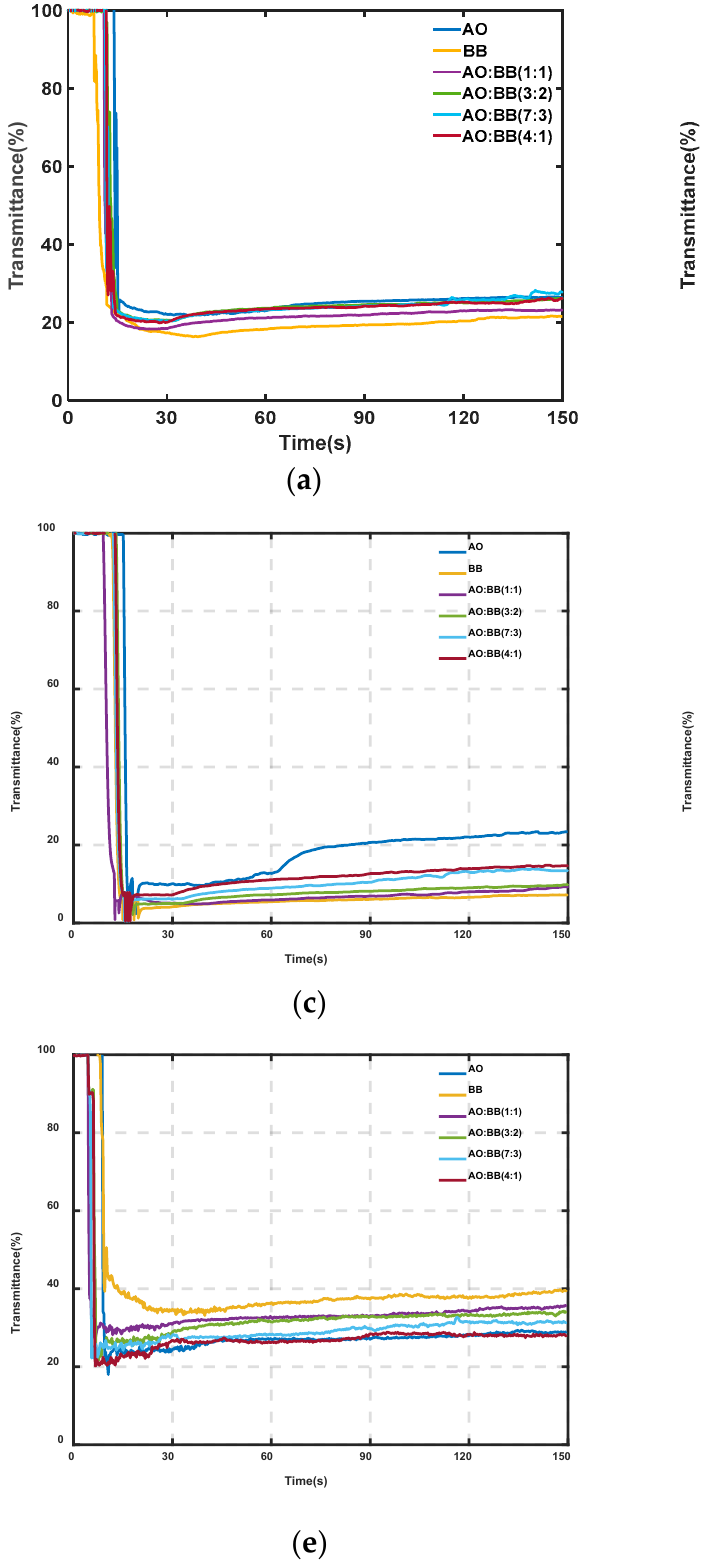
Figure 11. The broadband experimental transmittance of compound bioaerosols. ( a ) UV band. ( b ) Vis band. ( c ) NIR band. ( d ) MIR band. ( e ) FIR band.